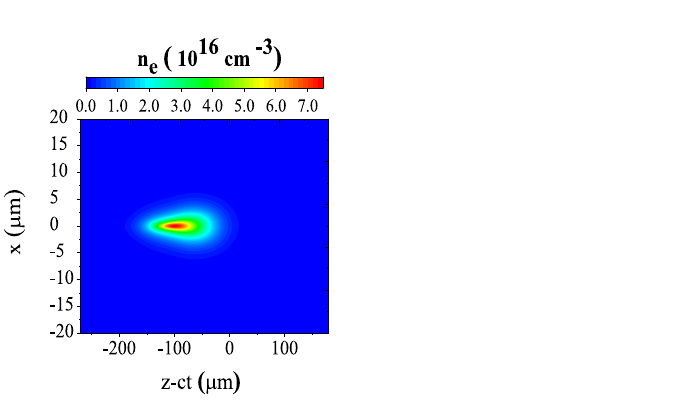
Figure 4. Density distribution of the electron bunch with an initial peak density of n b0 t 1.4 ps . =